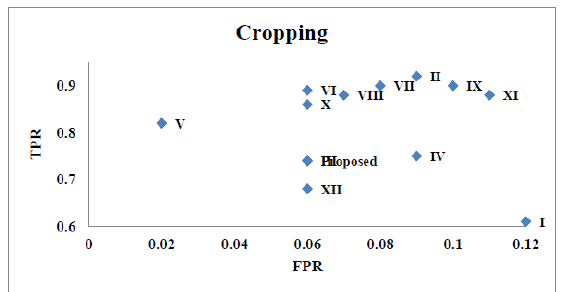
Figure 4. TPR vs. FPR: